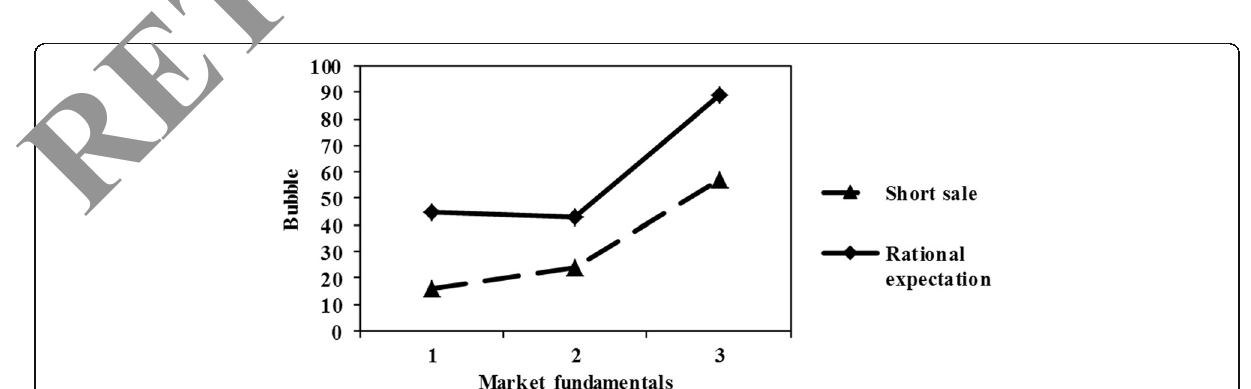
Fig. 4 Comparison of recommended algorithms